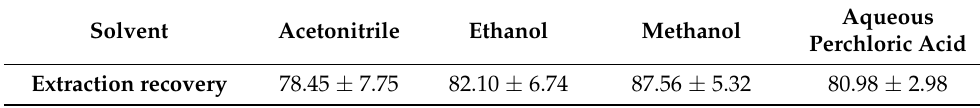
Table 1. Extraction recoveries of different tested